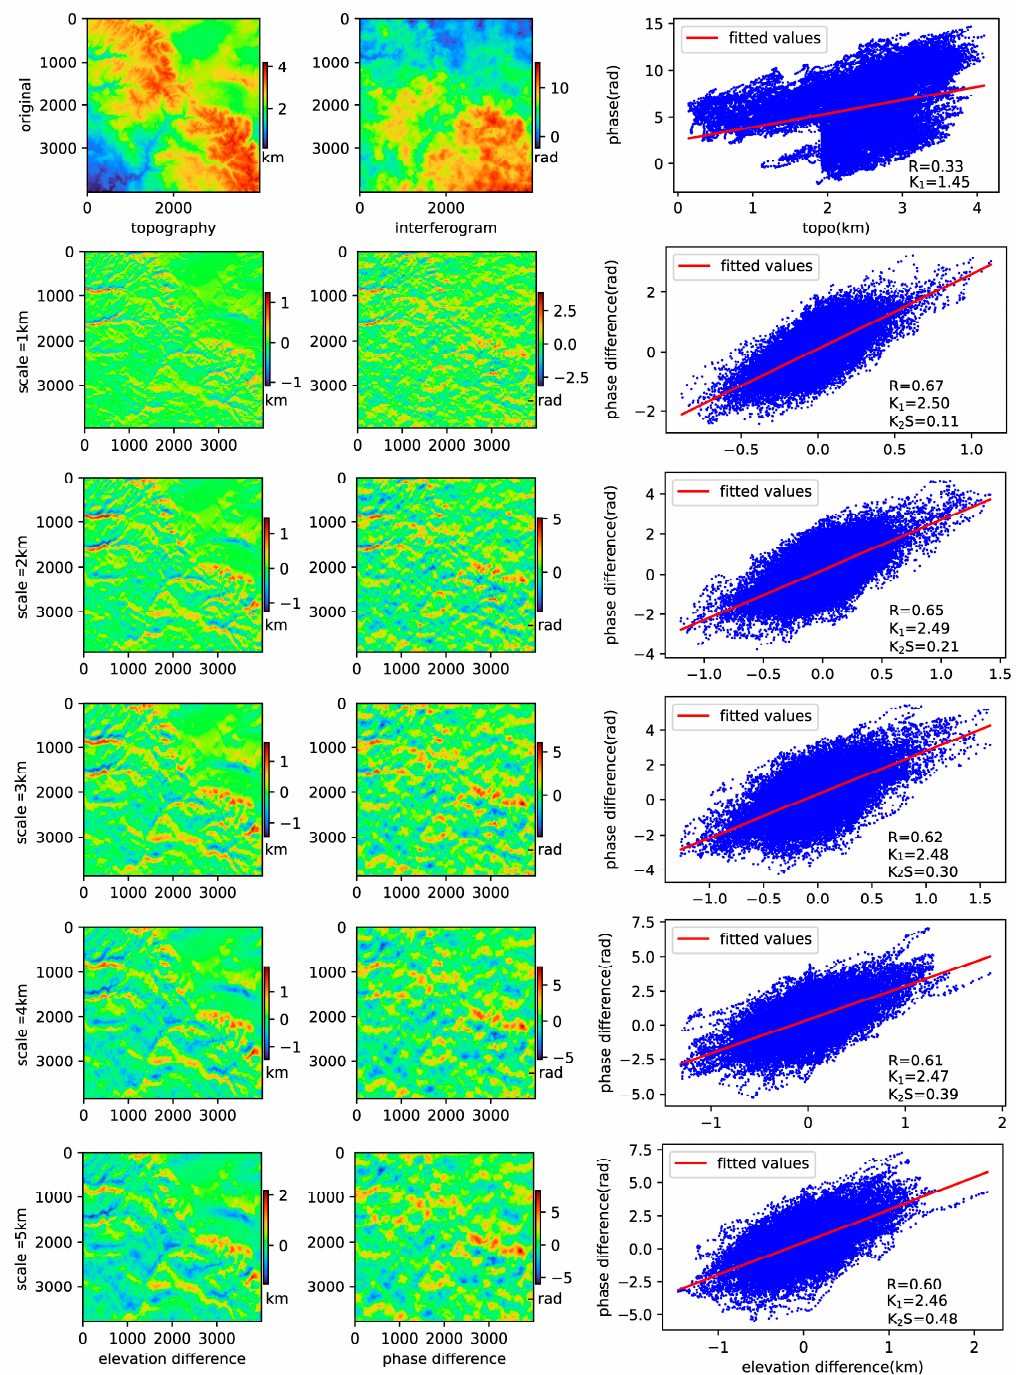
Figure 1. Original ( top ) and differential topography ( first column ) and interferogram ( second column ) with scale factors of 1 km, 2 km, 3 km, 4 km, and 5 km, respectively. The last column is the scatter plots of phase differences and topographic height differences. The scatter plots are diluted 300 times, and the direction of difference is azimuth 0 ◦ . The estimated values of K 1 , K 2 S , and correlation coefficient R for each scale factor are shown at the bottom right corners of the scatter plots. The final estimate values of K 1 and K 2 S are 2.50 rad/km and 0.1 rad/km, respectively, which are equal to the values set in the synthetic test (2.5 rad/km and 0.1 rad/km). In comparison, the K 1 value calculated using full interferogram–topography correlation is 1.81